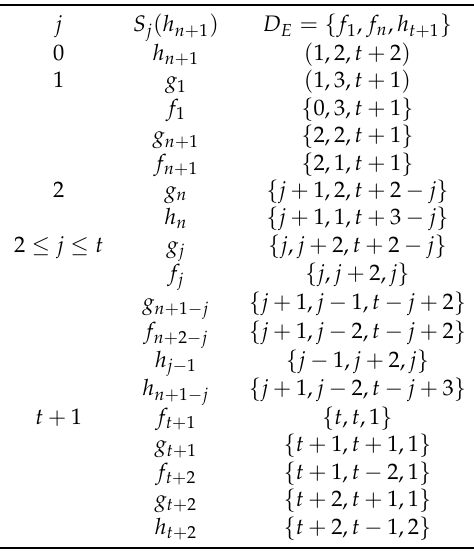
Table 4. Vectors of edge version of representations of N e